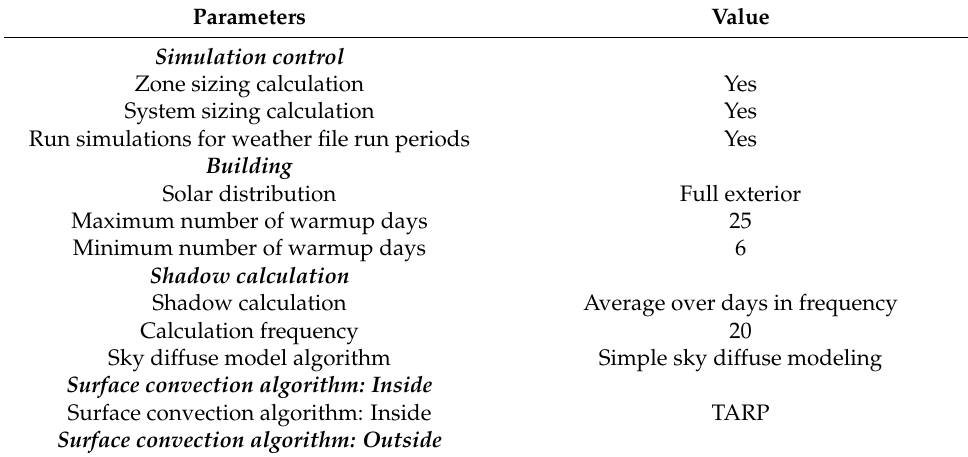
Table 4. Key case simulation